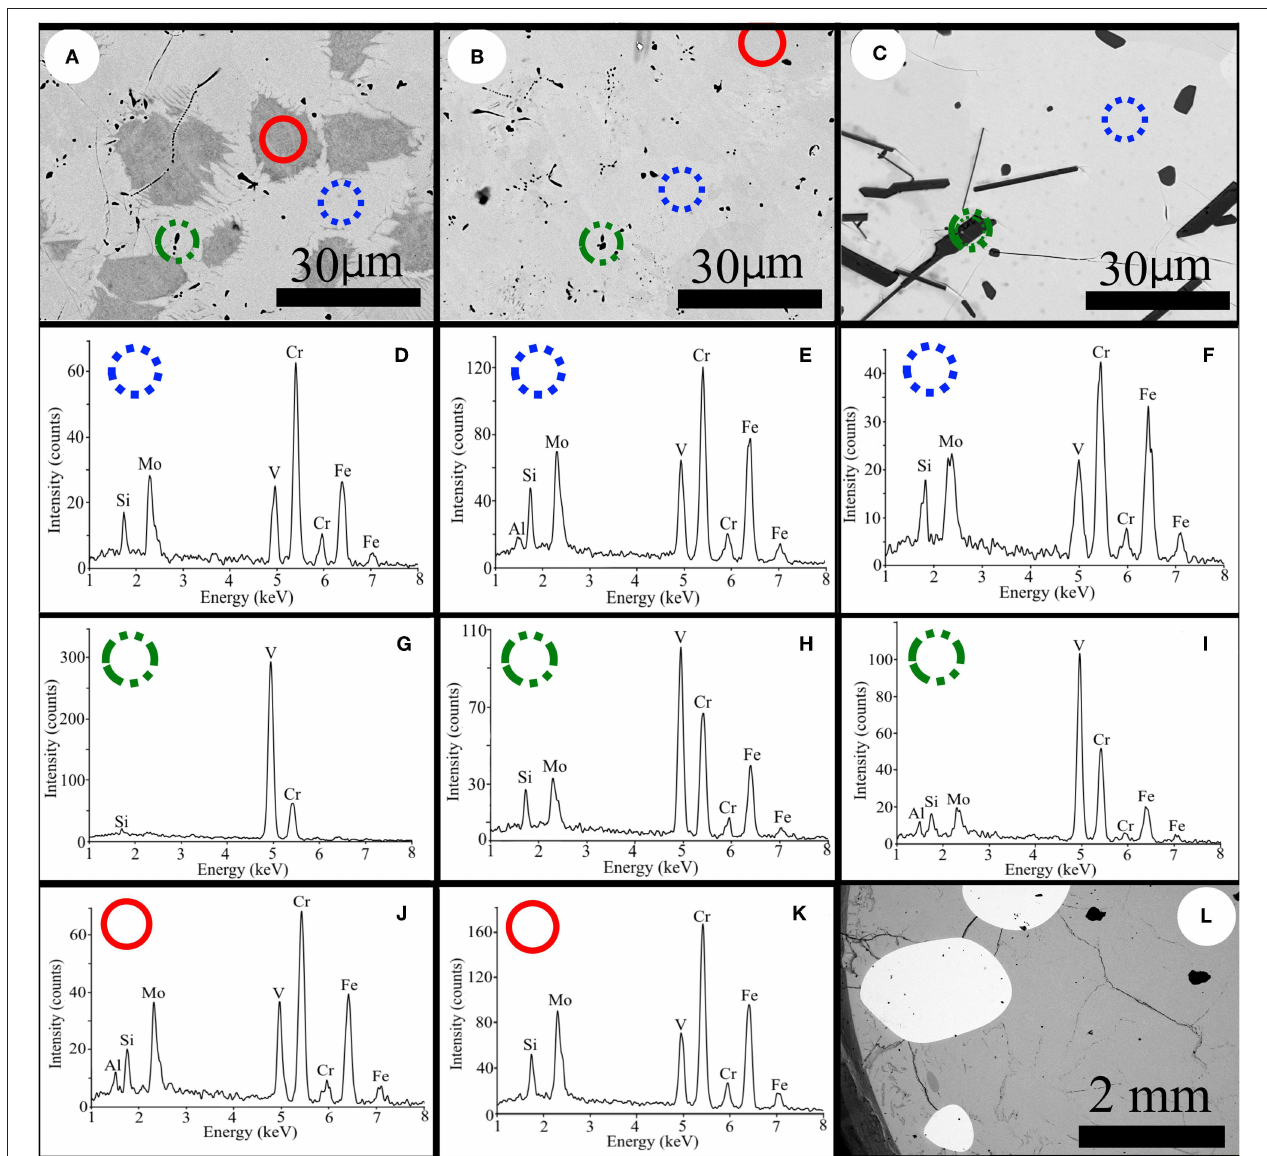
FIGURE 6 | Backscattered electron images of SiFeVCrMo (A) as-cast, (B) after annealing at 991 ◦ C (0.5 T m ) for 48h, and (C) after annealing at 1289 ◦ C (0.65 T m ) for 48h. EDX spectra (D,G,J) collected from the as-cast sample, (E,H,K) from the sample annealed at 0.5 T m , and (F,I) from the sample annealed at 0.65 T m . A low magnification image of the as-cast alloy is shown in (L)